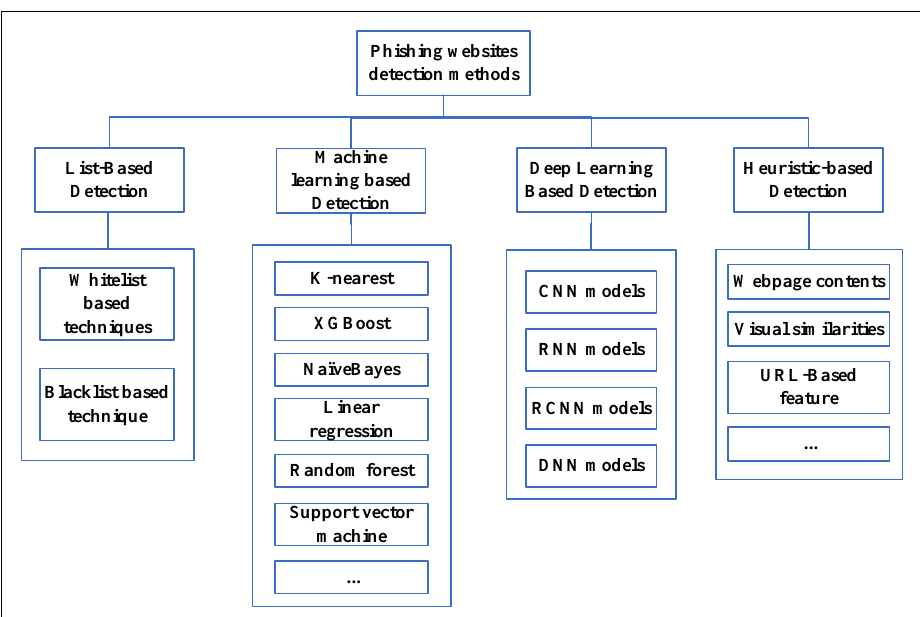
Figure 2. Category of phishing detection